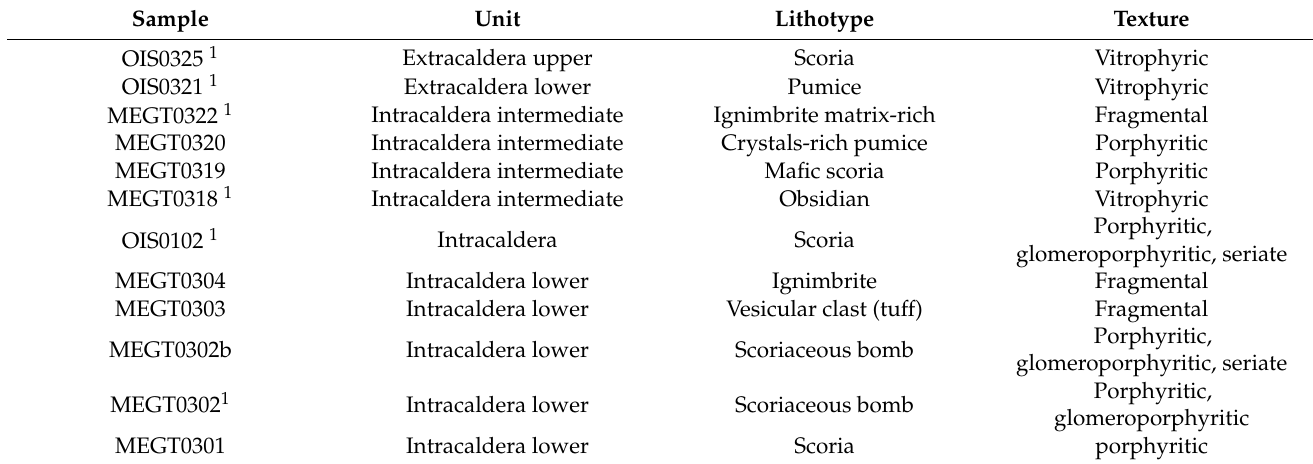
Table 1. Main petrographic features of the investigated MEGT